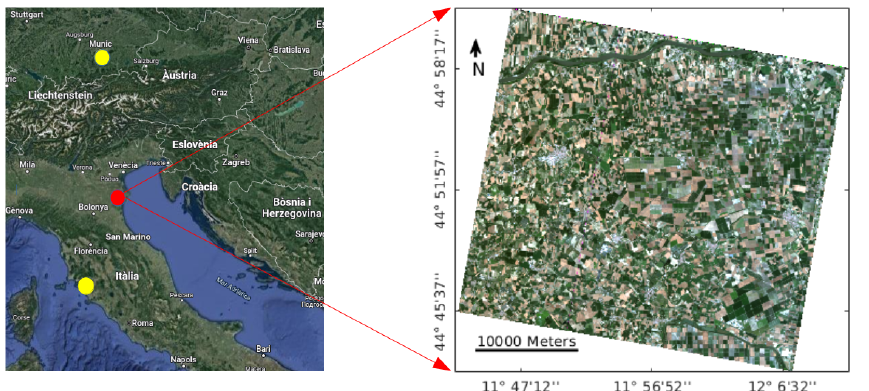
Figure 2. Zoom-in with PRISMA scene at the test site Jolanda di Savoia, Italy. The Grosseto and MNI test sites are also indicated as yellow